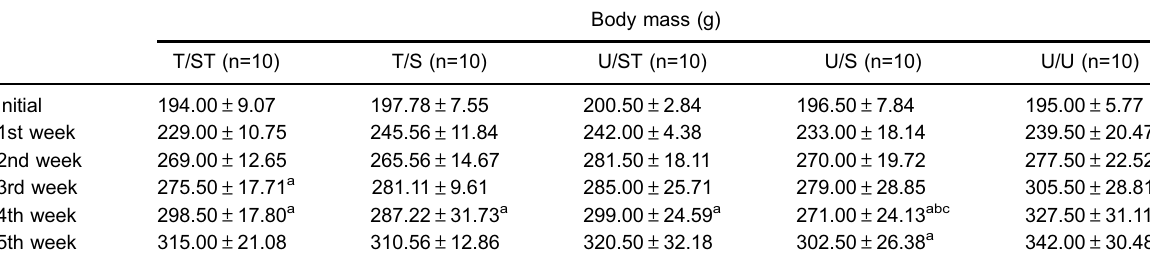
Table 1. Body mass during experiment.